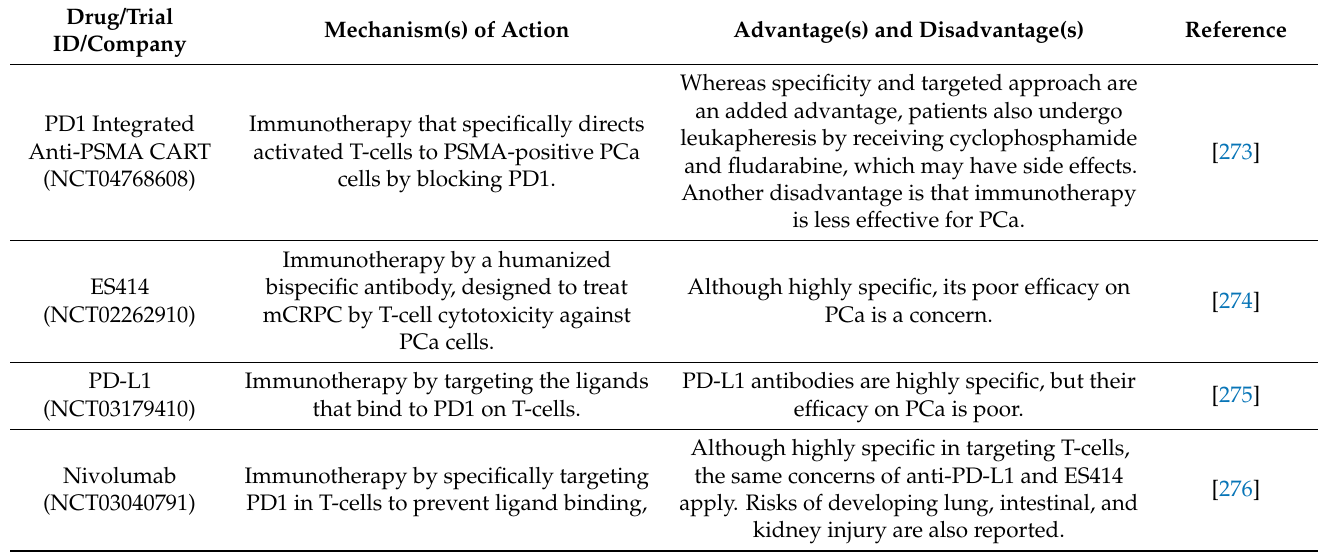
Table 3. Recently Approved and Future Therapies in Development for the Treatment of